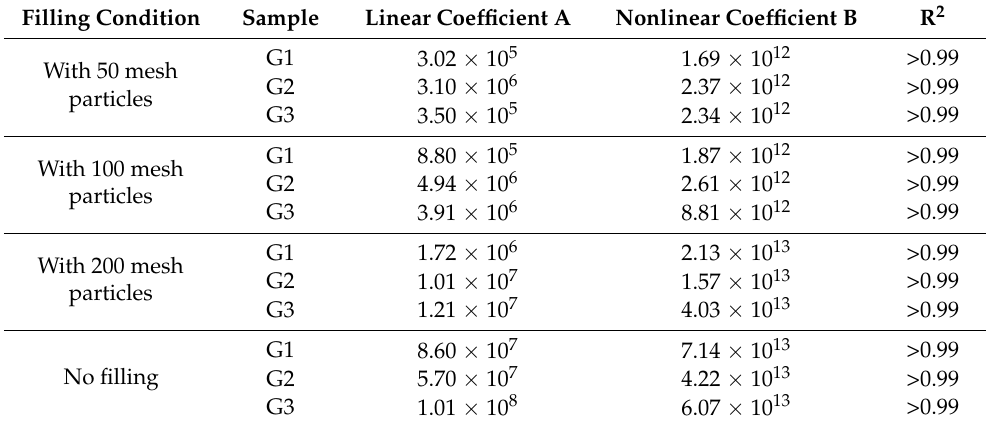
Table 2. Fitting results of coefficient of the nonlinear